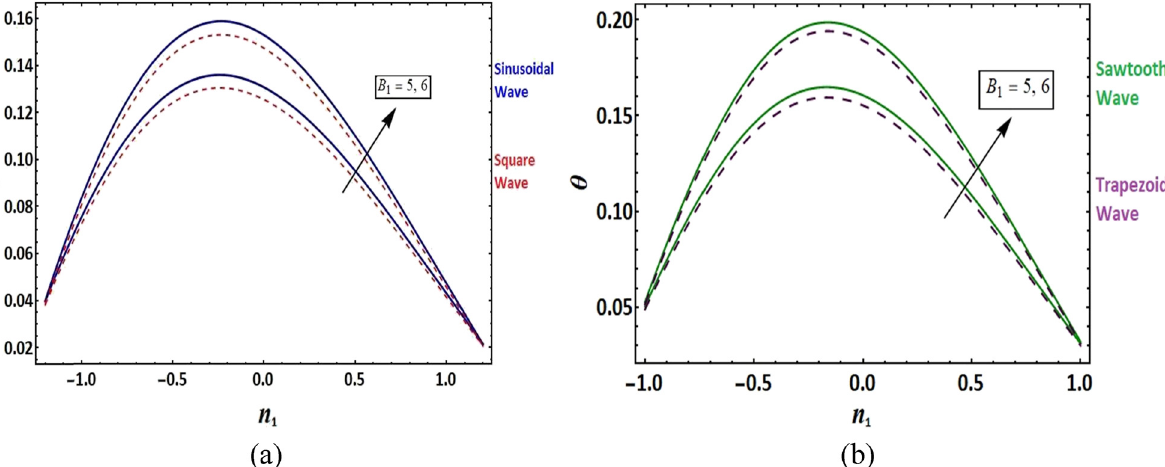
Figure 14: ( a and b ) Temperature pro fi le for λ 1 = 0.5, M = 0.2, Sc = 0.5, ϕ and B 5 2 = .